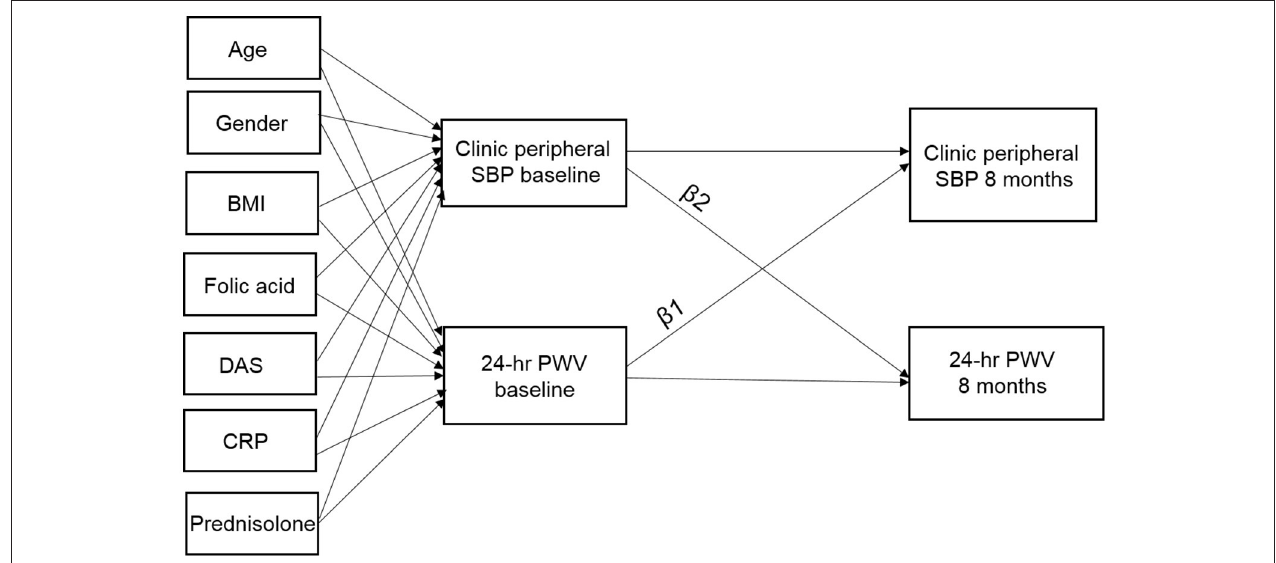
FIGURE 1 | β 1 , cross-lagged path coefficient from baseline PWV to follow-up clinic peripheral systolic blood pressure (SBP); β 2 , cross-lagged path coefficient from baseline clinic peripheral SBP to follow-up PWV. Baseline measures of age, gender, BMI, DAS, serum CRP, and use of folic acid and prednisolone are included as covariates. Arrows indicate hypothesized causal directions and when significant in the cross-lagged path analysis this provides an indication of